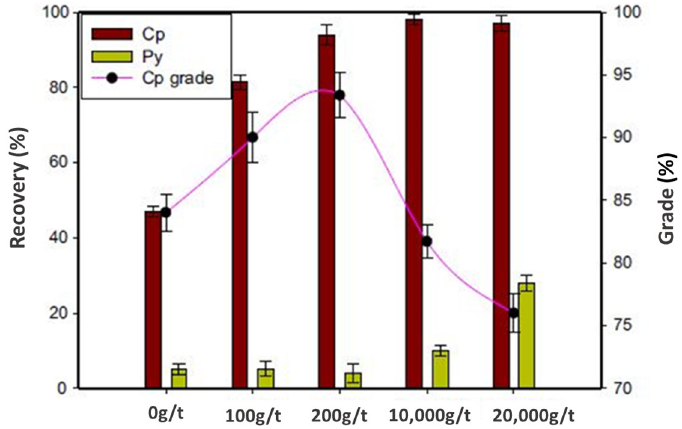
Figure 17. Chalcopyrite and pyrite recoveries, as well as chalcopyrite grade data, as a function of canola oil dosage for a 50:50 chalcopyrite–pyrite mixture [140].